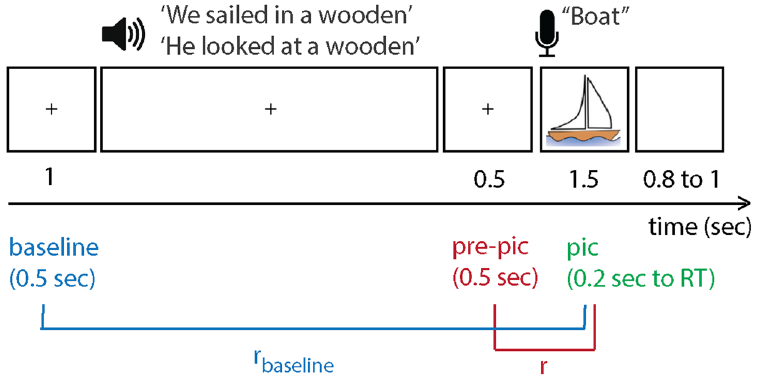
Figure 1. Experimental trial: participants listened to sentences that either built high or low expectations on upcoming pictures (pic) to be named. After a 0.5 s silent gap, participants named the picture that completed the sentence. We tested if the similarity-distance between the pattern of activity in the high frequency band during picture and pre-picture intervals predicted the RTs, by calculating the Spearman correlation coefficient (r). We